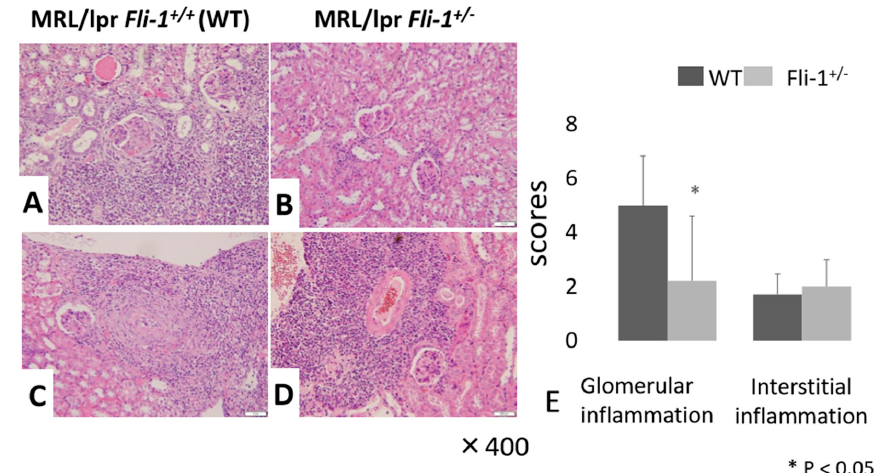
Figure 2. Renal pathology findings (Hematoxylin and Eosin (H&E) staining) in MRL / lpr Fli-1 +/+ (WT) and MRL / lpr Fli-1 +/ − mice. ( A – D , E ) H& E staining ( A – D ) and pathology scores ( E ) of glomerulus (Glom) and interstitial infiltrates (Int) in the kidney of age-matched, adult (4 months old or older) mice are shown ( n = 7–9 per groups); * p < 0.05 is considered as significant.